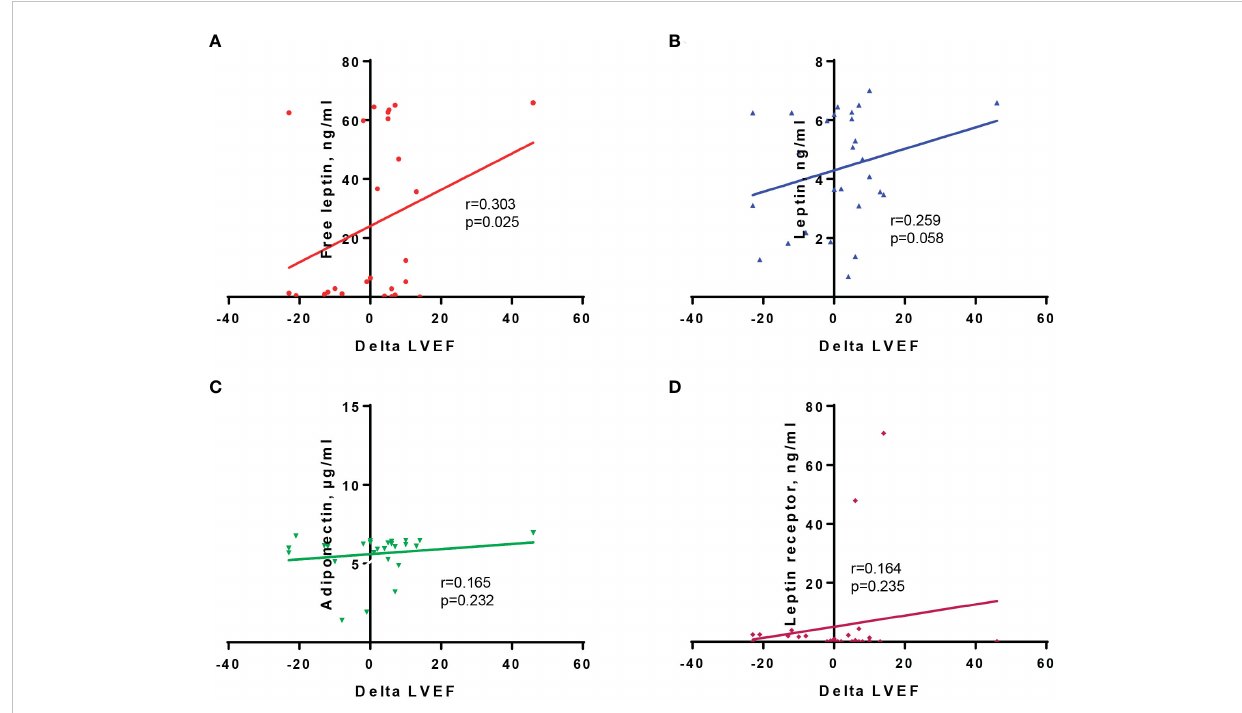
FIGURE 2 Correlation between delta-LVEF values and baseline serum levels of free leptin (A) , leptin (B) , adiponectin (C) , and leptin receptor (D)